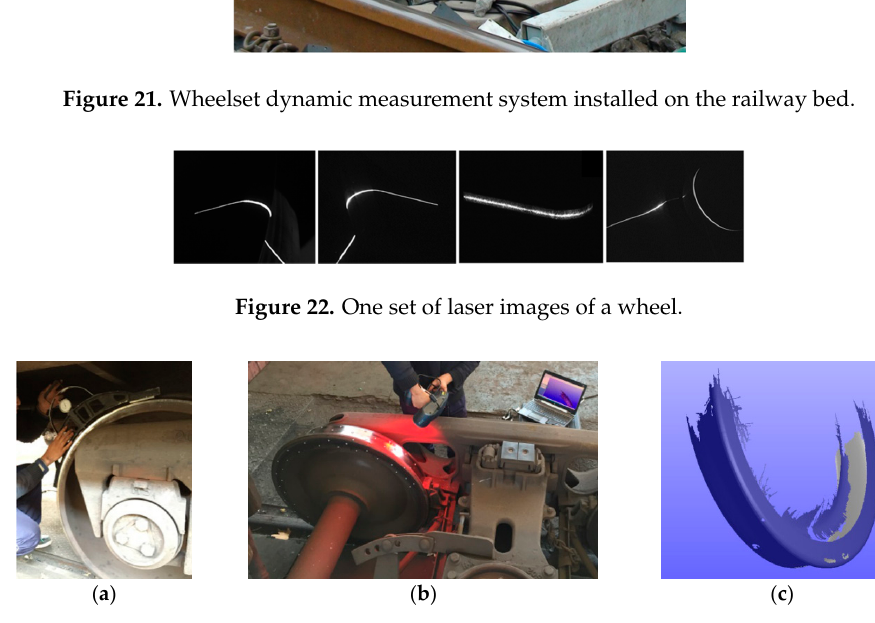
Figure 24. The diameter results of the wheelset axle.